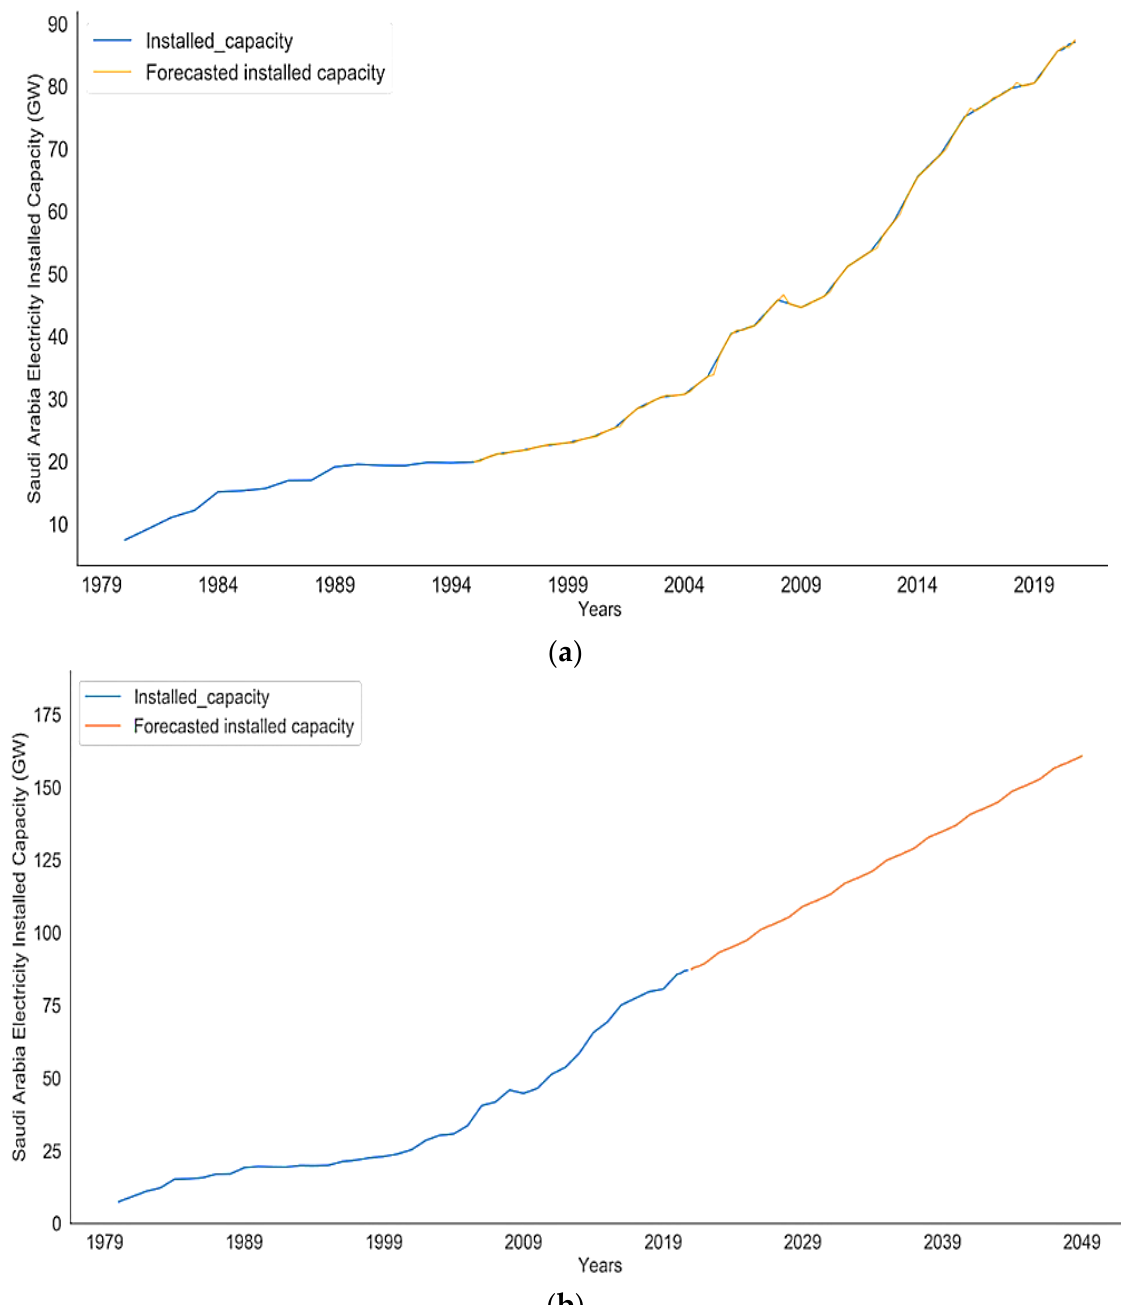
Figure 8. ( a ) Real and forecasted values of the electricity peak load, which show the good fit and performance of the SARIMAX model. ( b ) Forecasted peak electricity load values for the 30-year period from 2021 to 2050.